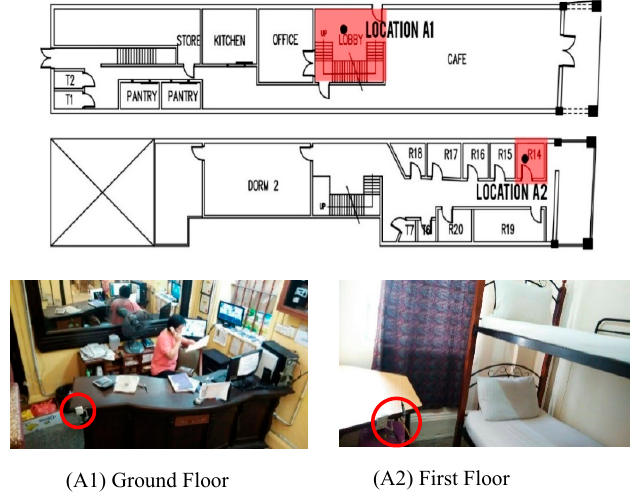
Figure 4. Location of data loggers in Building A.